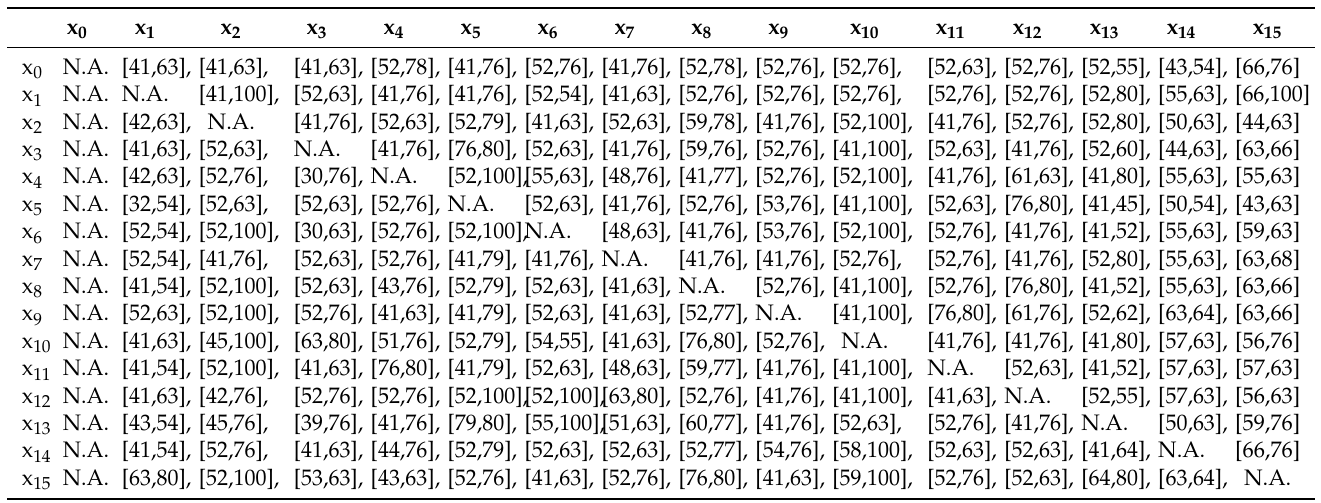
Table A3. Fuzzy costs for the objective O 3